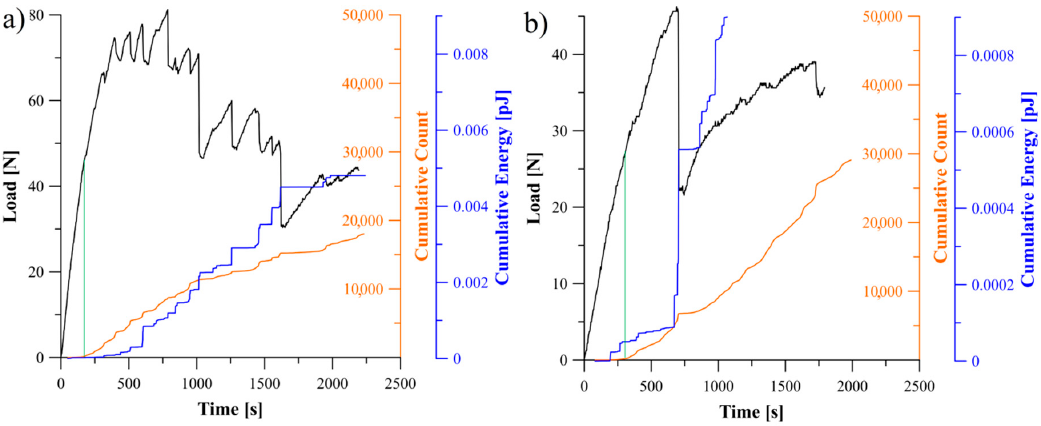
Figure 10. Relation between load, cumulative count and energy of AE signal obtained during the DCB experiment: ( a ) for specimen with 30°// − 30° delamination interface, ( b ) for specimen with 45°// − 45° delamination interface.